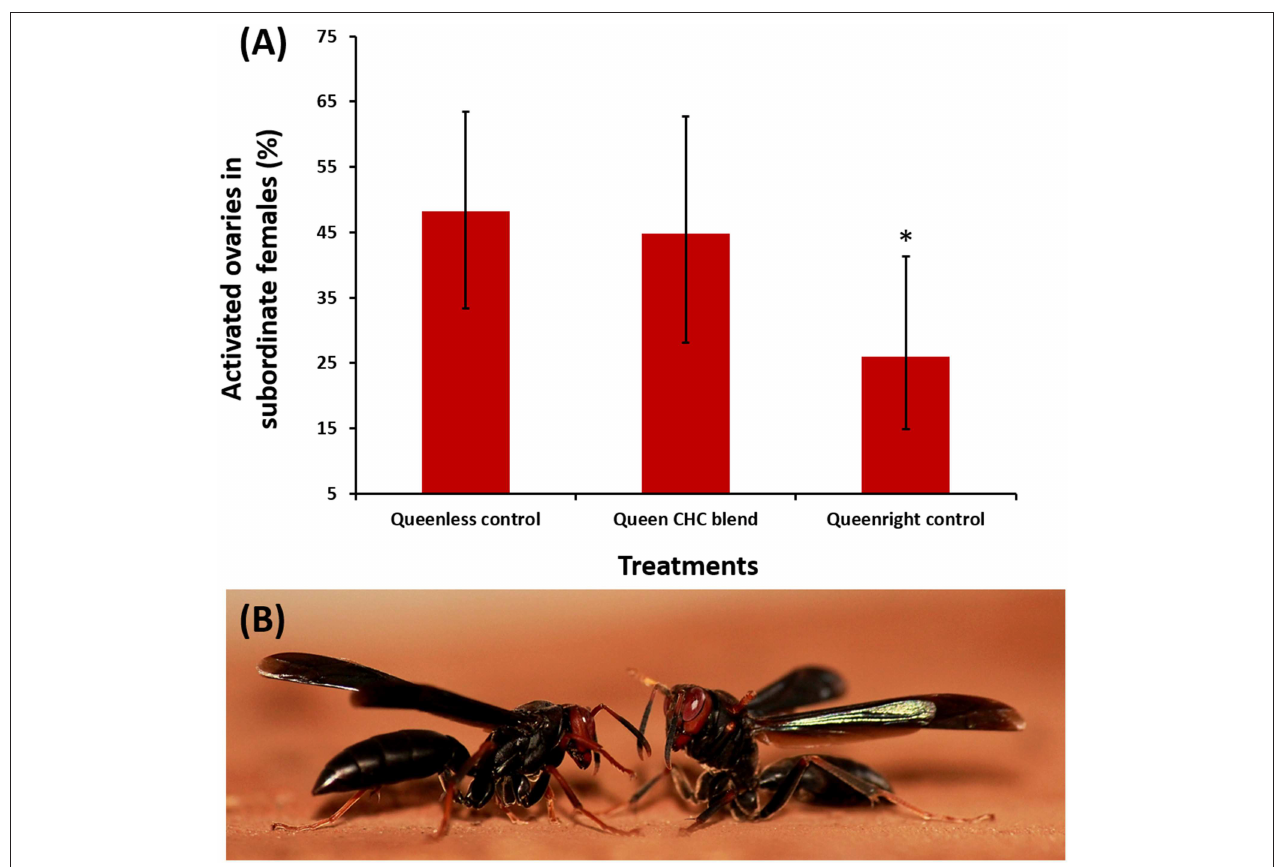
FIGURE 2 | (A) Percentages of subordinate Polistes satan females with developed ovaries, across the different treatments of our queen pheromone bioassays. The proportion of females with developed ovaries in nests which were treated with a blend of compounds characteristic of the dominant breeding females (a mixture of tricosane, tetracosane, pentacosane, hentriacontane, and 3-methylheptacosane at two queen equivalents, middle bar) was not significantly different than that in a queenless solvent-only control (left bar). In contrast, physical presence of the dominant female significantly reduced ovary development among subordinate females (right bar, binomial GLMM, z = − 2.05, * p = 0.039) (Control N = 6 nests/ n = 81; blend N = 7 nests/ n = 58; queenright N = 7 nests/ n = 74); (B) Aggressive behavior between two females, characterized as “boxing,” observed during field trials. Boxing is characterized by alternating movements of the first two pairs of wasp legs and short advances toward the opponent ( Tannure-Nascimento, 2006). Photo credit: